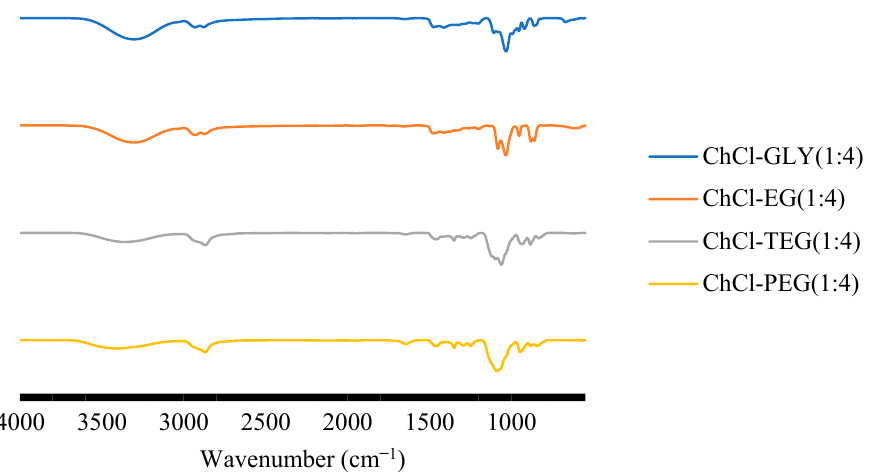
Figure 5. FTIR graph of DES with mole ratio of 1:4 hydrogen bond acceptor:hydrogen bond donor (HBA:HBD).